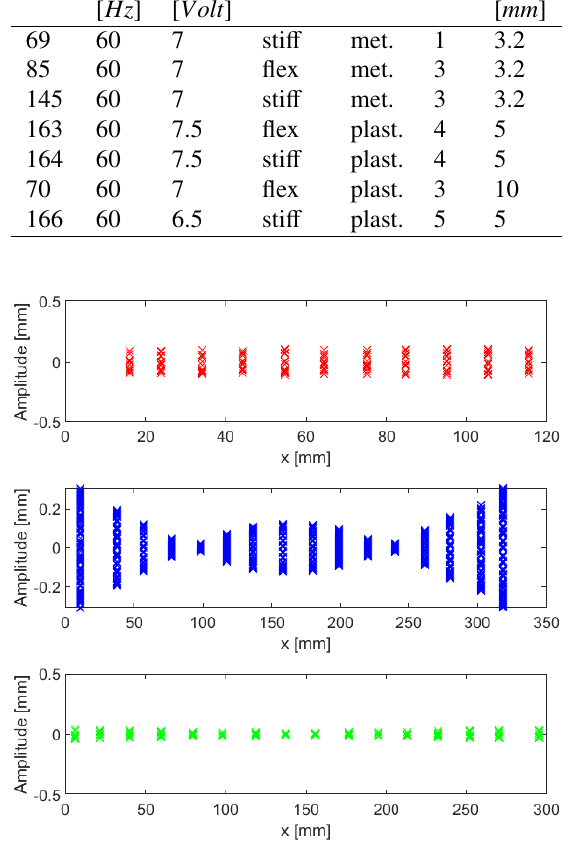
Fig. 2 : Flexion data of three di ff erent plates used for the exper- iments: the rigid-square metal plate (at the top), the flexible- rectangular metal one (in the middle) and the rigid-rectangular metal one (at the bottom).